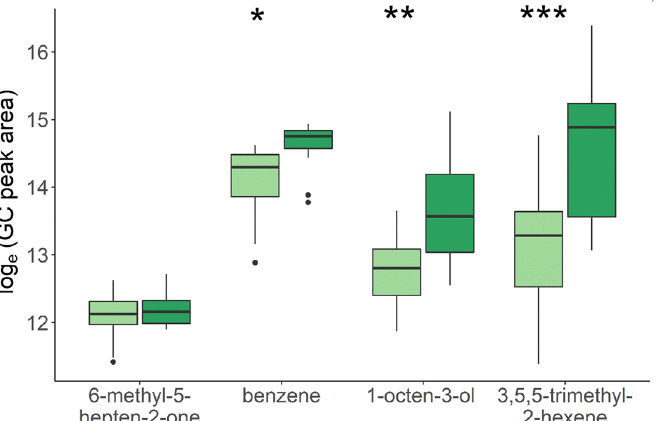
Figure 2. Boxplot and whisker plot showing differential expression (Loge to GC peak area) of 6-methyl-5- hepten-2-one, benzene, 1-octen-3-ol and 3,5,5-trimethyl-2-hexene (c) across genetically resistant GenR (light green n = 12) and susceptible GenS (dark green n = 12) lines, significance level after Benjamini–Hochberg correction (*p < 0.05; **p < 0.01; ***p < 0.001). Median is given as solid line, box is the interquartile range and whiskers are 1.5 times the interquartile